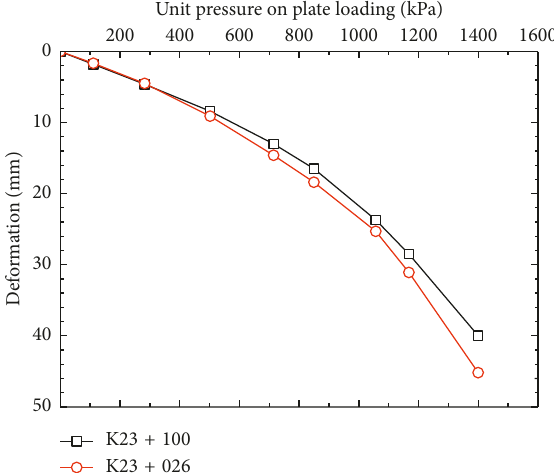
Figure 12: Stress-deformation curve of plate loading test on fly ash after dynamic consolidation.